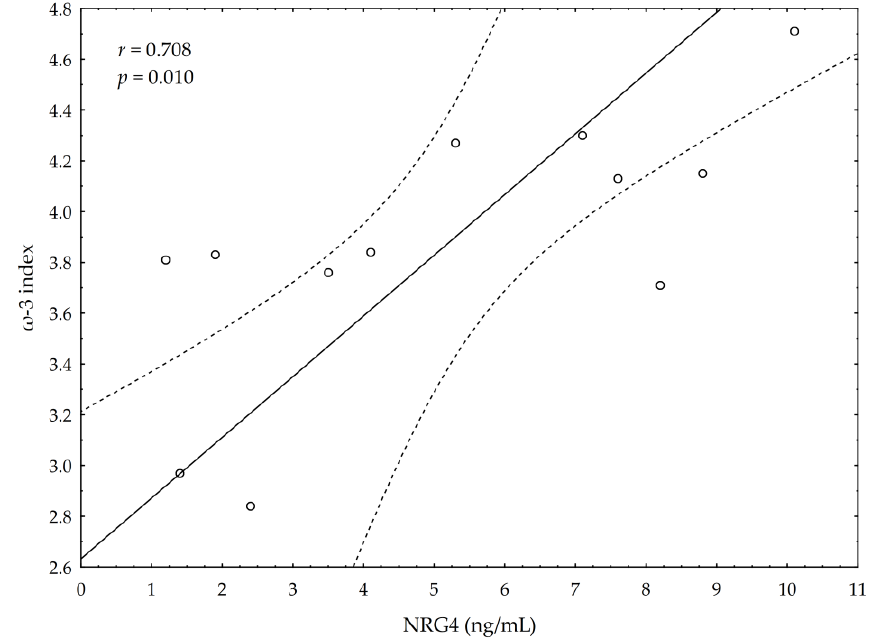
Figure 2. Correlations between omega-3 index ( ω -3 index) and serum neuregulin 4 (NRG4) levels.